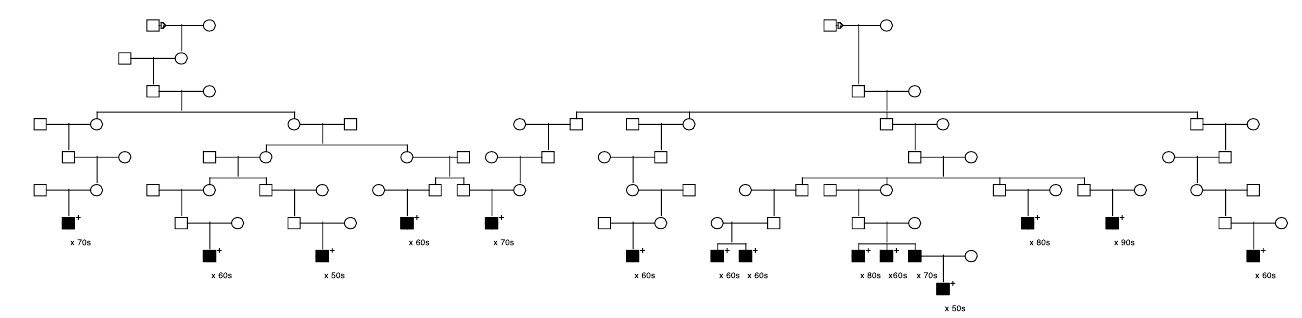
Figure 5. High-risk prostate cancer pedigree segregating a rare DUOX2 variant.